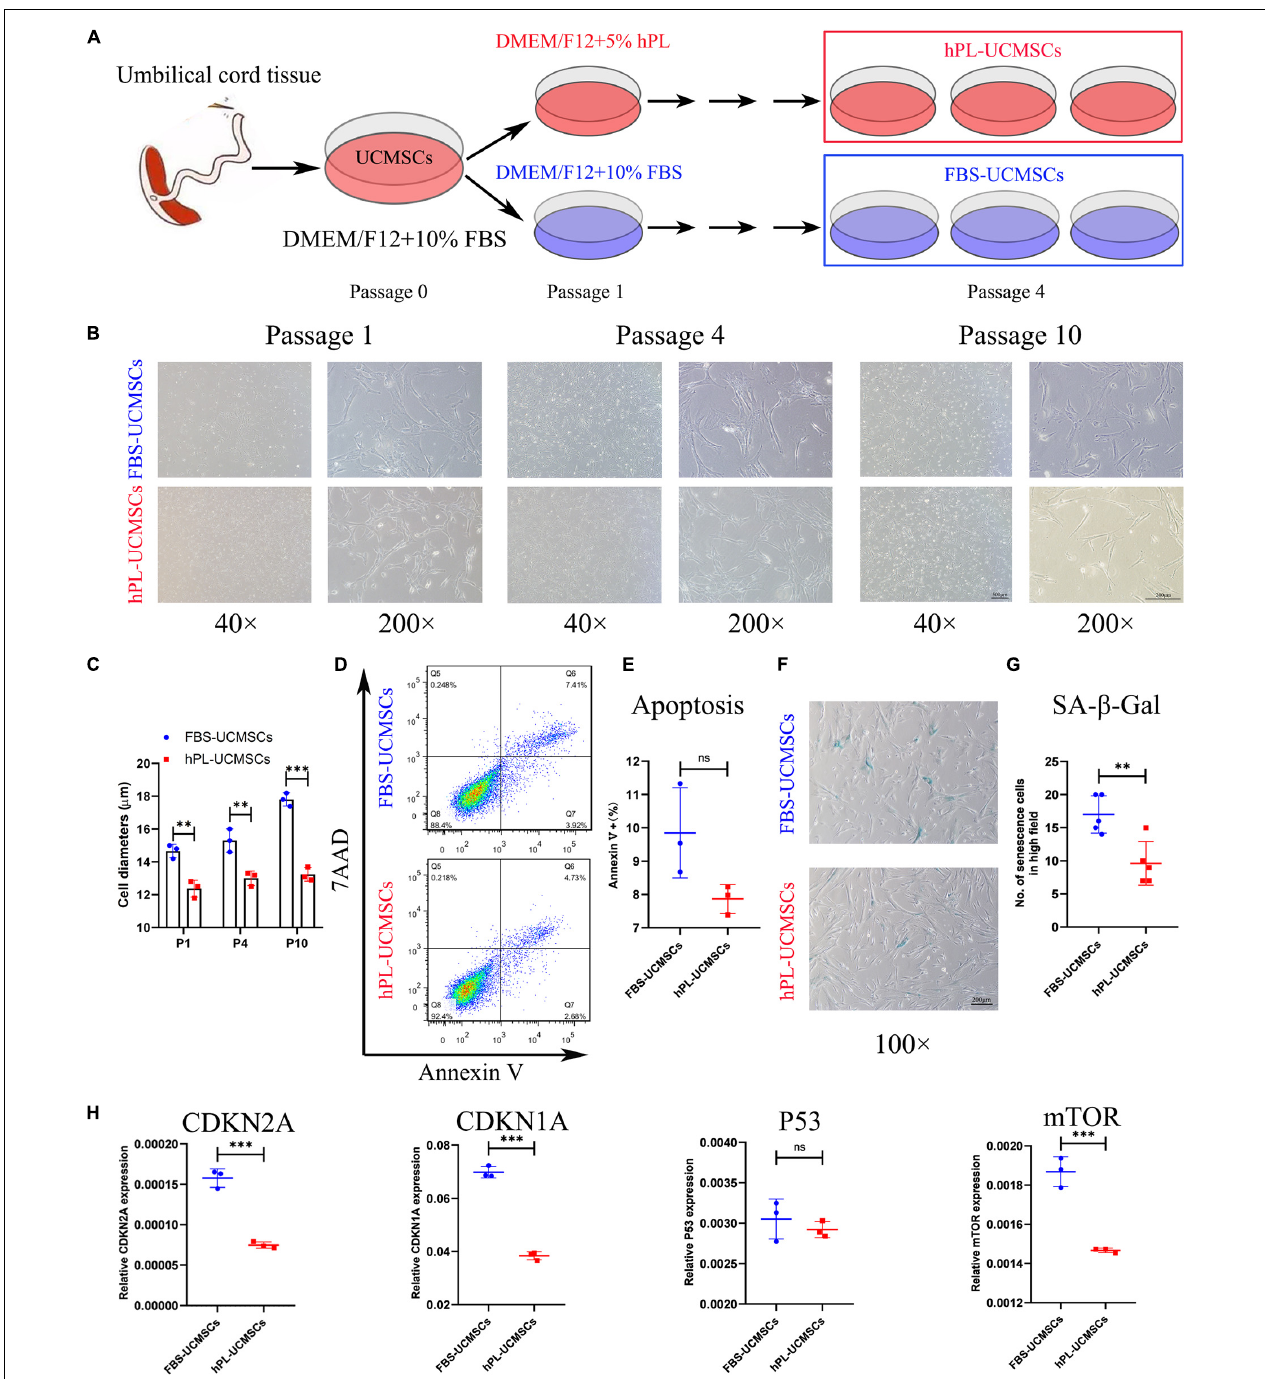
FIGURE 1 | Growth supplement hPL could largely reduce the senescence of UC-MSCs in vitro expansion compared with FBS. (A) Schematic of protocols used for UC-MSCs in vitro expansion with either FBS-supplemented (10% FBS) or hPL-supplemented (5% hPL) media for up to 10 passages. Representative images showing the morphology of UC-MSCs changes notably as a result of serial passaging (from P1 to P10) between the FBS- and hPL-supplemented groups (B) ; and the cell diameters in both groups were measured (C) . Scale bars, 100 µ m (40 × ) or 200 µ m (200 × ). At Passage 10, the cell apoptosis of FBS-UCMSCs and hPL-UCMSCs were analyzed using flow cytometry by staining with Annexin V and 7AAD reagent (D) ; and the percentage of Annexin V + cells was compared between these two groups (E) . At Passage 10, the cell senescence of FBS-UCMSCs and hPL-UCMSCs were analyzed by staining with β -galactosidase reagent (F) . Scale bars, 200 µ m; and the count of SA- β -Gal positive cells in high field (100 × ) was compared (G) . (H) The mRNA expressions of senescence-related gene (CDKN2A, CDKN1A, P53, and mTOR) in P10 FBS-UCMSCs and hPL-UCMSCs were analyzed by qPCR. Data are shown as mean ± SEM. n = 3–5. ∗∗ p < 0.01, ∗∗∗ p < 0.001. ns, not